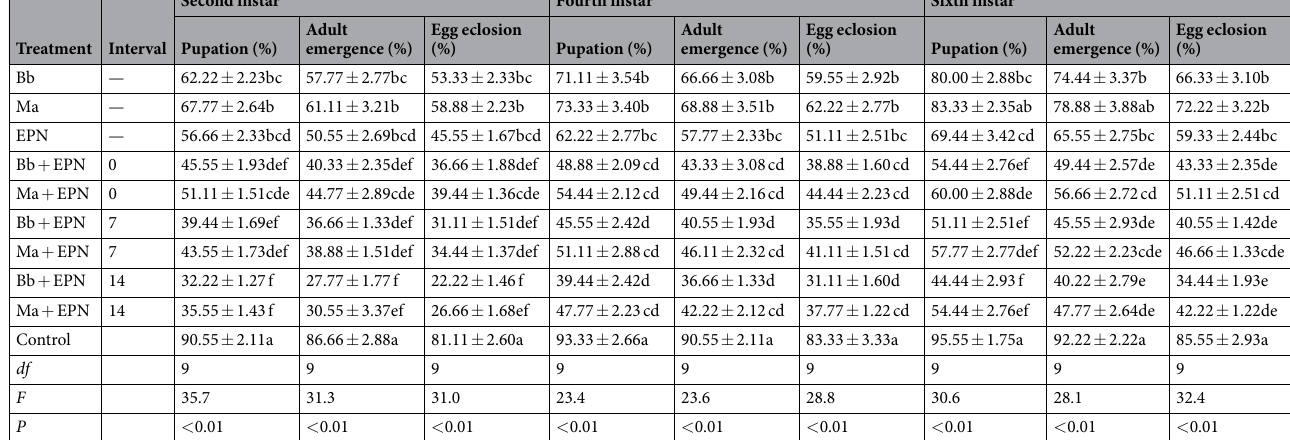
Table 5. Pupation, adult emergence and egg eclosion (% ± SE) of 2 nd , 4 th and 6 th instar R. ferrugineus larvae treated with Beauveria bassiana (1 × 10 6 spore ml − 1 ) , Metarhizium anisopliae (1 × 10 6 spore ml − 1 ) and Heterorhabditis bacteriophora (100 IJs ml − 1 ). Mean sharing the same letters are not significantly different at 5% level (Bb: Beauveria bassiana , Ma: Metarhizium anisopliae , EPN: Heterorhabditis bacteriophora , IJs: Infective Juveniles).